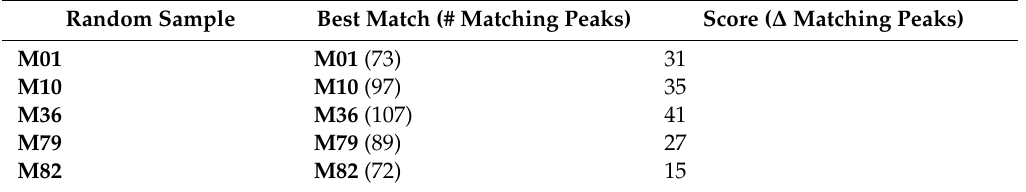
Table 1. The number of matching peaks identified by the software for the best match of the randomly selected antibodies M1, M10, M36, M79, and M82. The score gives the di ff erence between the number of matching peaks of the best and second-best